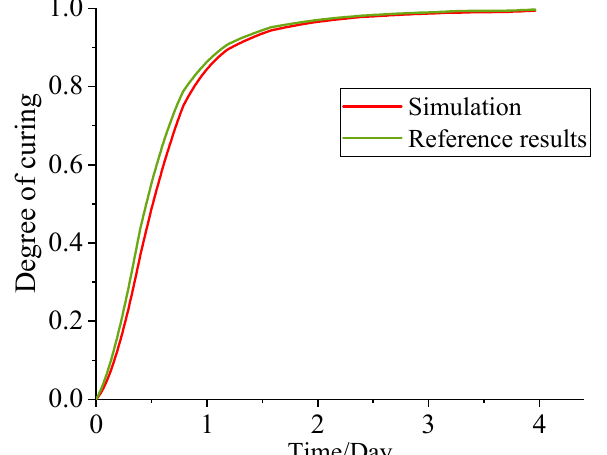
Figure 4. Comparison of the cure degree between the simulation and the result of Ref. [21] at 50 °C.